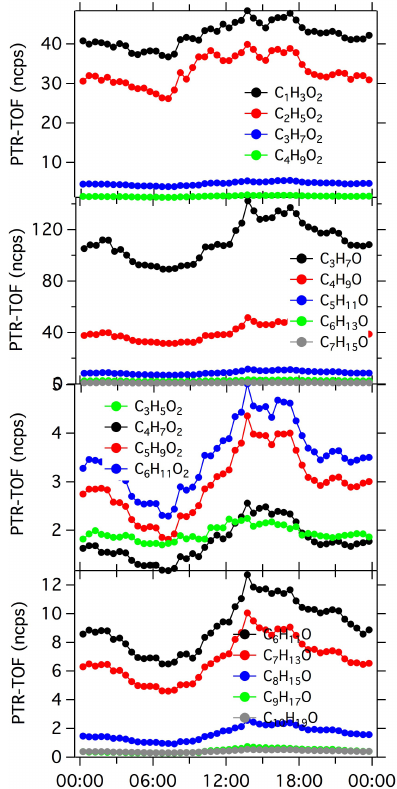
Figure 11. PTR-TOF diurnal variation of selected oxygenated VOCs during UBWOS2013. Many of those compounds cannot be unambiguously identified with